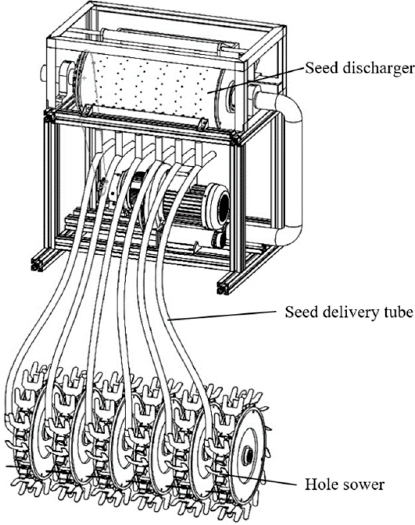
Figure 1. Split seeding